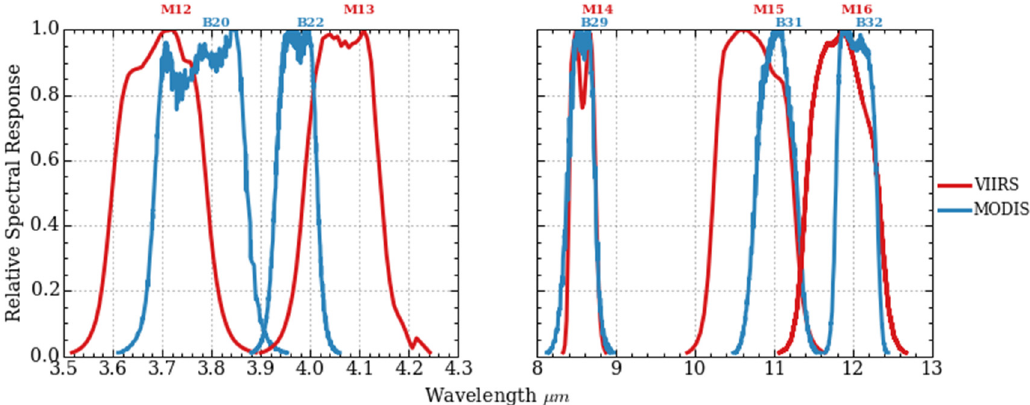
Table 2. Relative Bias drift [K/3.5 years] between S-VIIRS and A-MODIS.